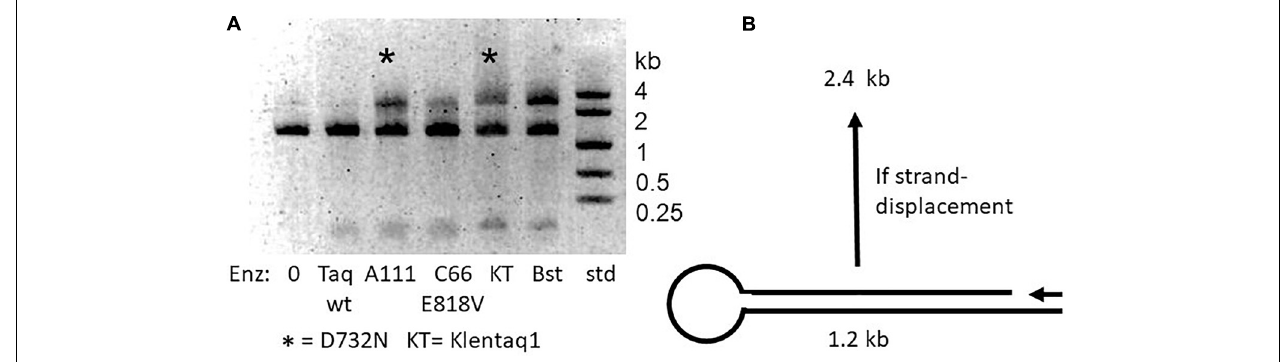
FIGURE 2 | Strand-displacement by mutant enzymes with D732N. (A) Half-dumbbell test. Catalyzed DNA synthesis begins at the primer (arrow) and proceeds to and through the loop and back again, only if the polymerase is capable of strand displacement, to make a product 2.4 kb in size. The two D732N mutant versions of Taq (full-length A111 and Klentaq1) are marked with asterisk (*). Bst pol was expected to be able to strand-displace, and was included as a positive control. We explain unextended 1.2 kb template as due to inefficiency of the half-dumbbell construction at unknown point(s) during its preparation. (B) Discovery of LAMP ability. A multiply mutant form of Taq pol carrying D732N, named KTflnC4RR (lanes KT*, see text) was tested compared Manta (lanes M), a brand of the large fragment of Bst DNA polymerase (Enzymatics). The banded amplification product which is typical for LAMP appeared at 3 h incubation at 60 ◦ C for both enzymes but only for KT* enzyme at 70 ◦ C. The middle lane size standards were 1, 2, 4 kb.